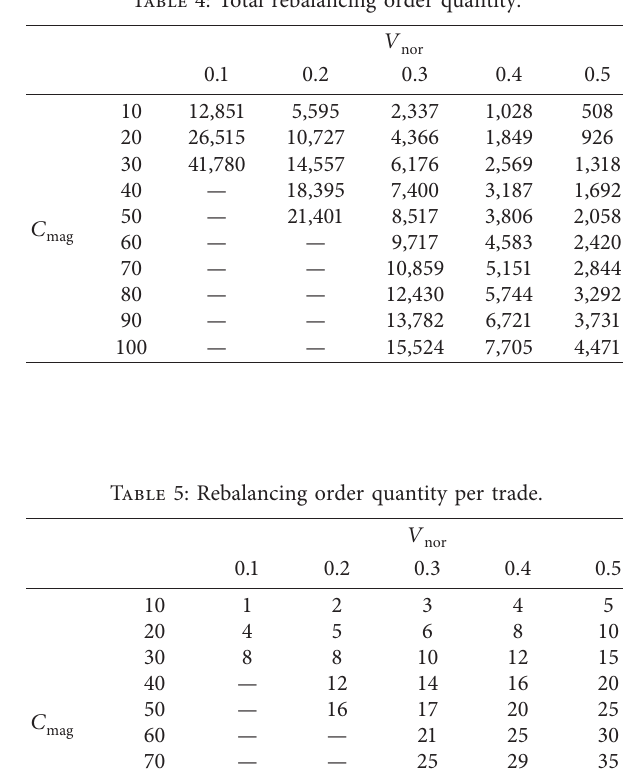
Table 4: Total rebalancing order quantity.